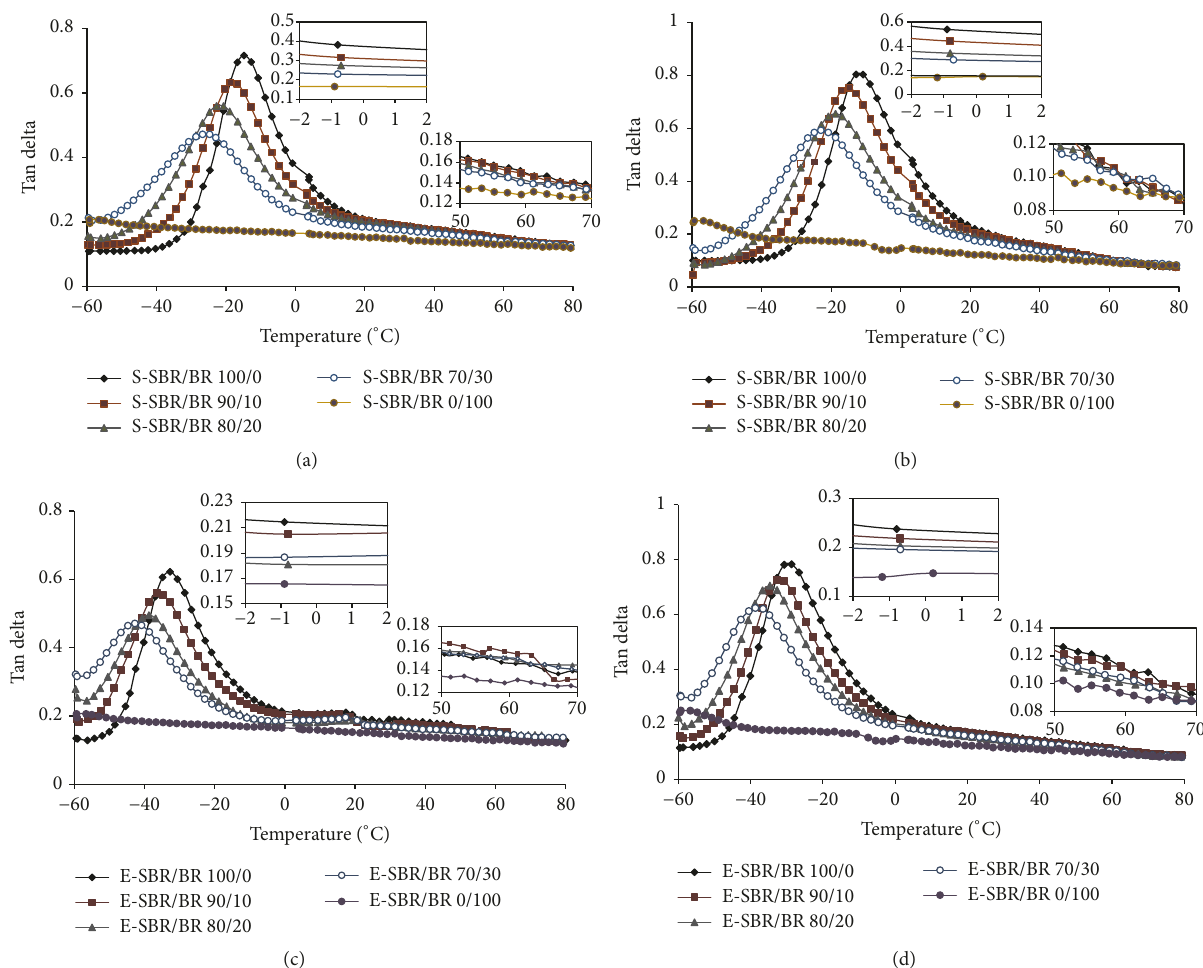
Figure 7: Dependence of tan 𝛿 on SBR/BR blend ratio of the rubber vulcanizates; (a) CB-filled S-SBR/BR, (b) SiO 2 -filled S-SBR/BR, (c) CB-filled E-SBR/BR, and (d) SiO 2 -filled